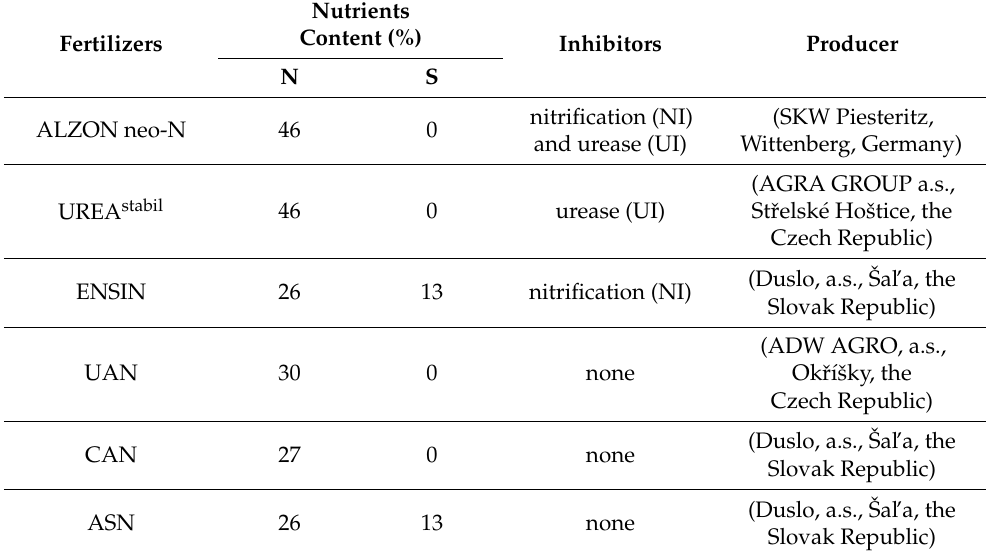
Table 3. Type of used